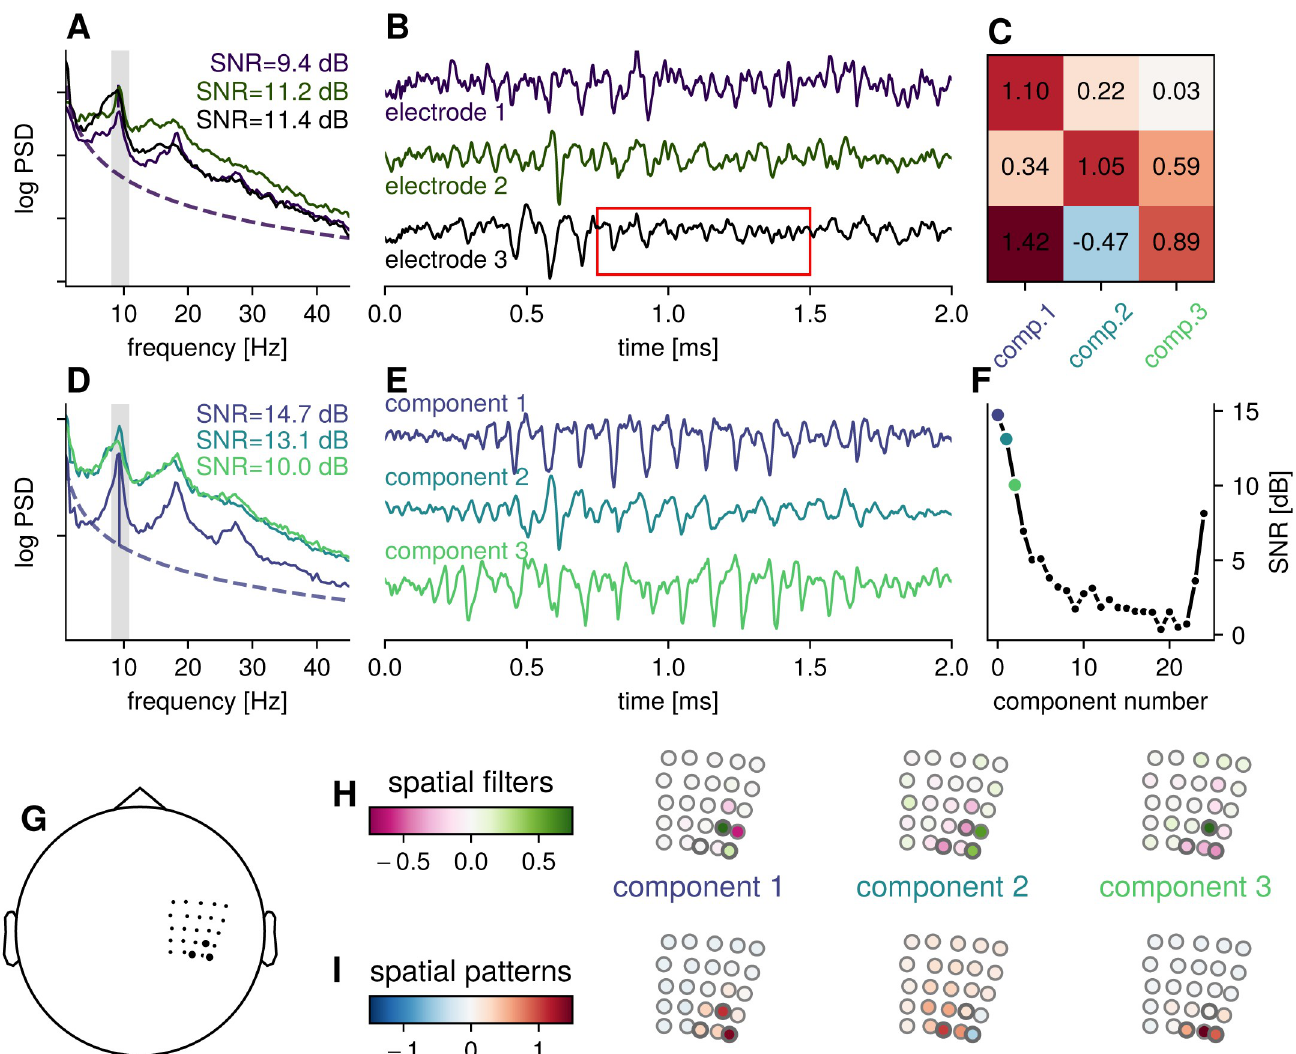
Fig 2. Example: Spatial mixing of sensorimotor rhythms for one participant. A) Power spectral densities for three channels along the sensorimotor strip. The gray bar indicates the frequency band defined as the signal contribution for estimating the SSD spatial filters. The power spectrum shows a peak frequency in the alpha-band, with additional harmonic peaks. The channels were selected a according to highest SNR in the chosen frequency range. B) The corresponding signal in the time domain showing oscillatory bursts in the alpha-band, amplitudes are normalized for comparison of time courses. The red box marks a time period in which less pronounced oscillations can be seen in the electrode signals, but the oscillatory power of the constituent SSD components is not decreased. C) Coefficients in the spatial patterns for the selected electrodes, i.e., electrode 2 can be approximated as a linear combination of: e 2 = 0.34 component 1 + 1.05 component 2 + 0.59 component 3 . D) Power spectral densities for the first three components as estimated by SSD, showing a higher alpha-SNR, with less spectral peaks in flanking frequency bands. E) Time domain signal for the corresponding three components, showing pronounced sensorimotor bursts, normalized amplitudes for comparison of time courses. F) SNR per component, for all 25 components. The SNR drops off fast, only a number of components need to be inspected. For the components last in the sequence, the SNR increases as rhythms in flanking bands increase spectral power also in the band of interest. G) Approximate location of the ECoG-grid in head coordinates. The black markers highlight the electrodes shown in A) and B). H) Spatial filter coefficients showing similarity to bipolar and Laplacian-type filters. I) Spatial pattern coefficients showing focal contributions from sources along the sensorimotor strip.